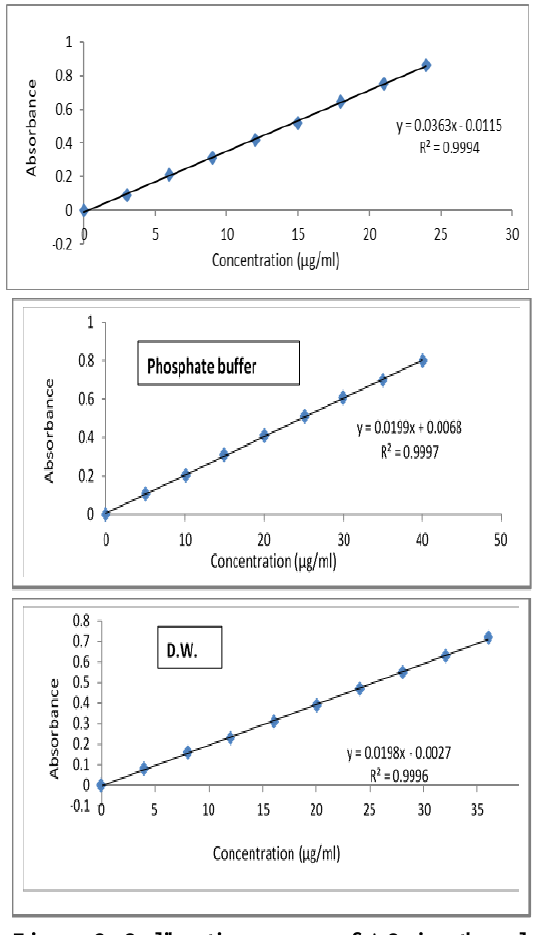
Figure 2. Calibration curves of AC in ethanol, phosphate buffer pH 7.4 and